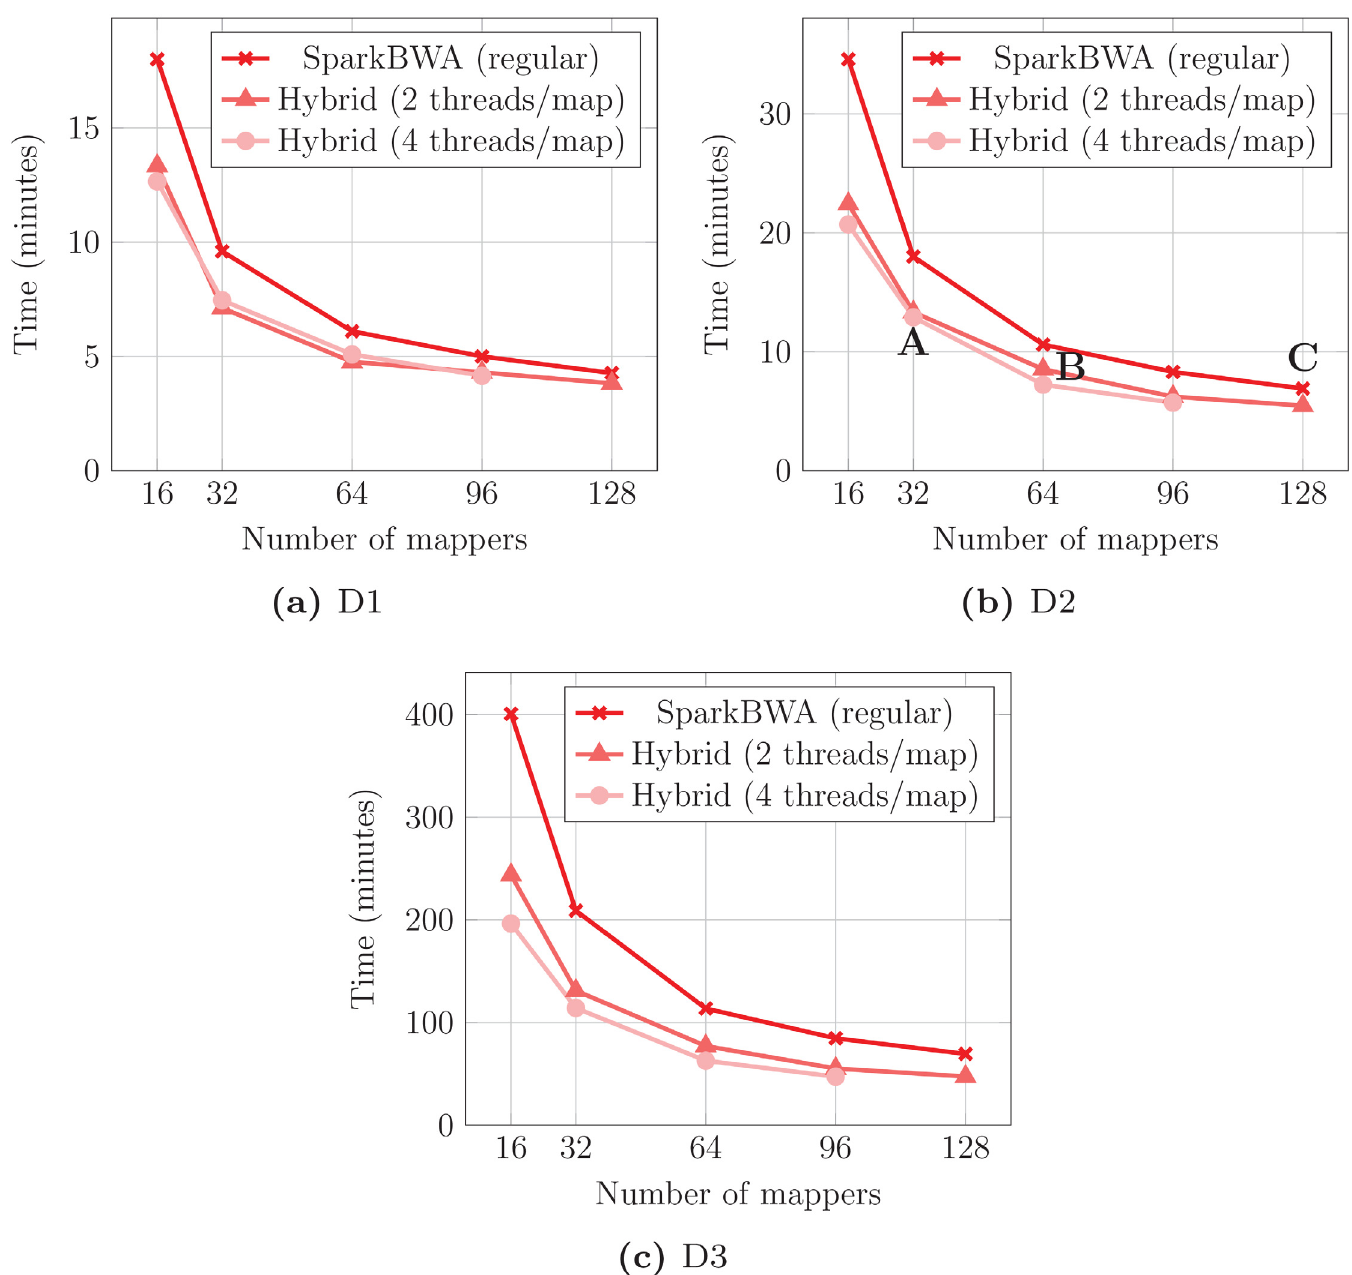
Fig 8. Execution times obtained by SparkBWA using regular and hybrid modes of operation for the BWA-MEM